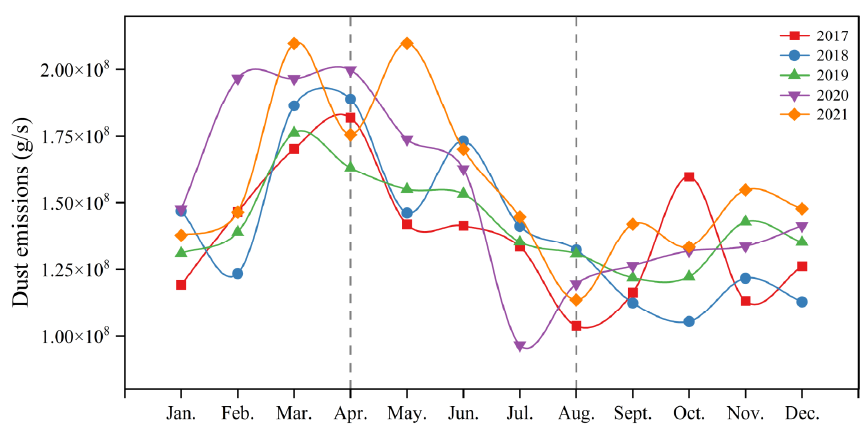
Figure 2. Global monthly dust emissions from agricultural land, 2017–2021.